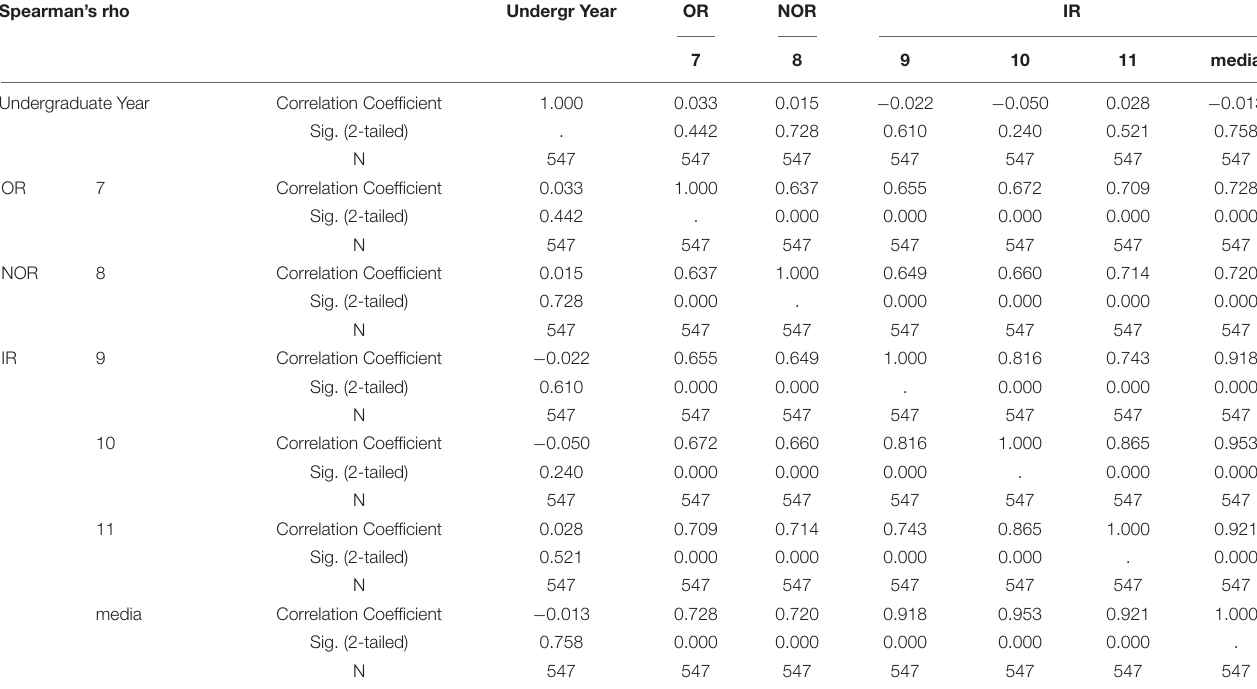
TABLE 9 | Spearman coefficient (s) – undergraduate year and Duke University Religious Index